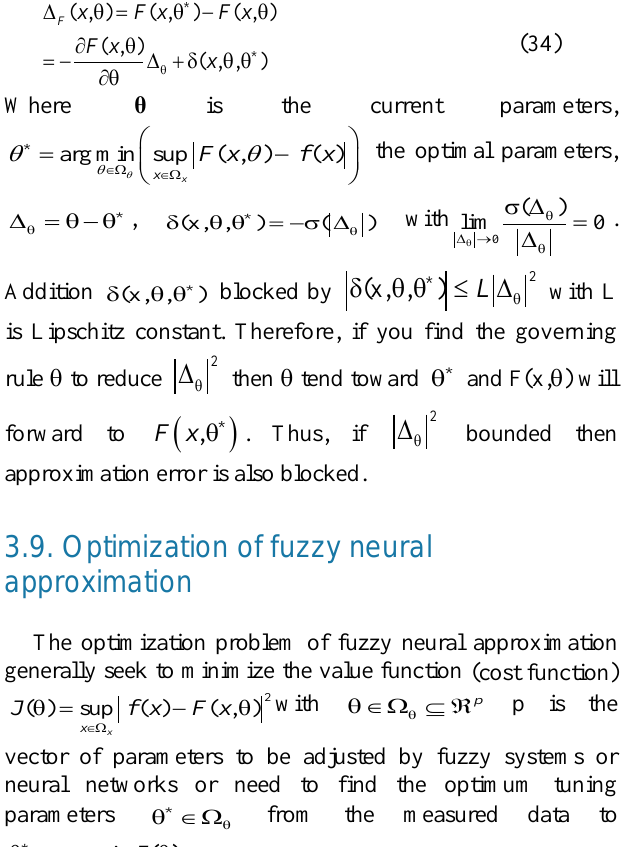
Figure 10. Architecture of FNNREM